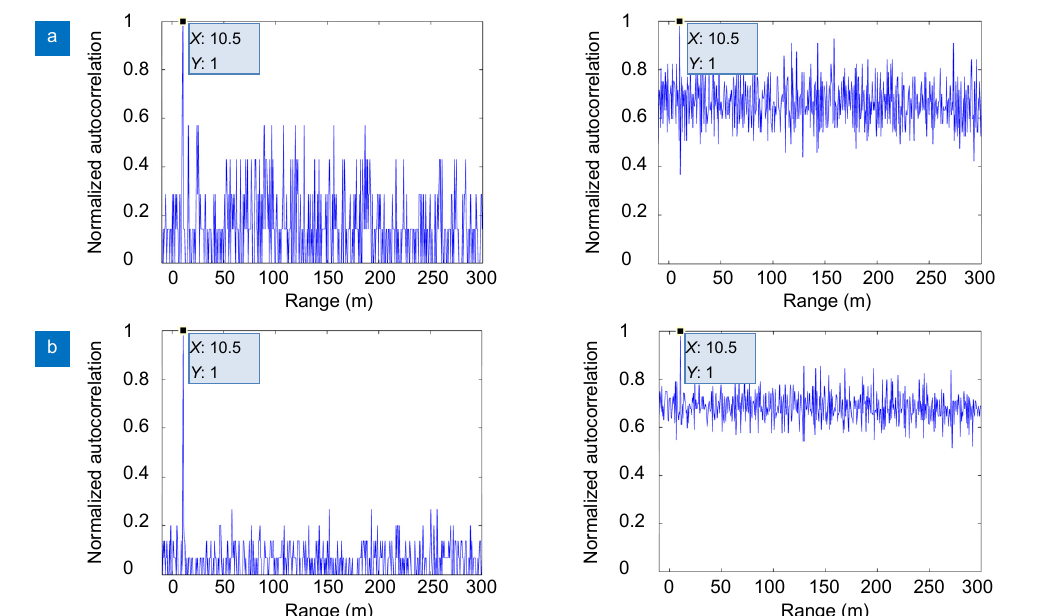
Fig. 4 | Normalized auto-correlation range images with two different echo photons number for the true random coded method and the pseudo-random coded method.